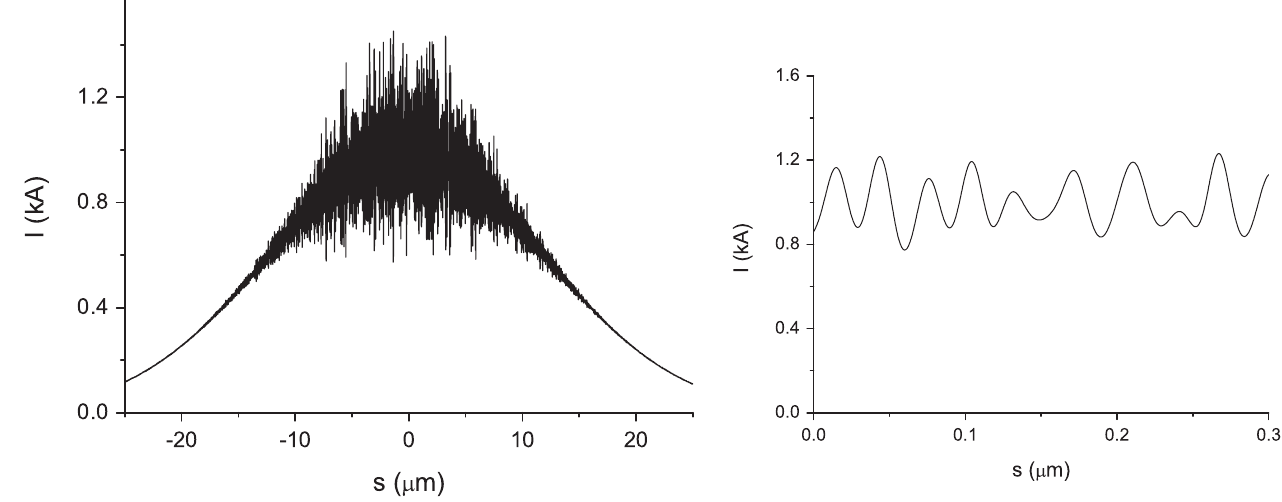
FIG. 6. Modulated electron bunch (left) and its enlarged fraction (right) after the third amplification cascade. The calculations were performed with LOSCA .